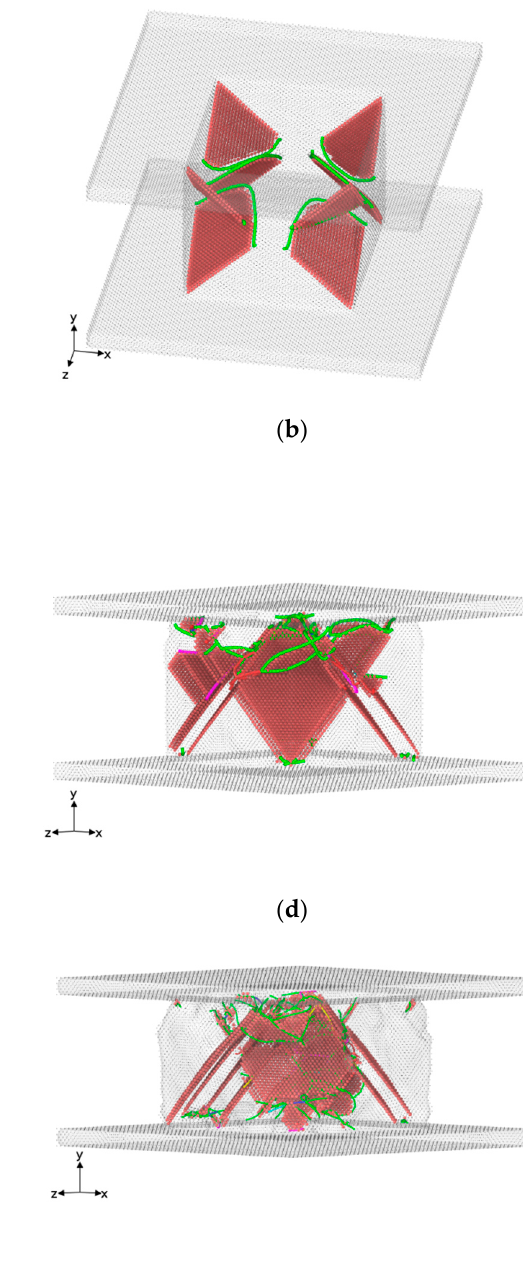
( b ) Figure 14. Deformation patterns in a simulated <001> Ni single crystal with {100} lateral faces: ( a ) h/d=2, ε =27%; ( b ) h/d=1, ε =22%.